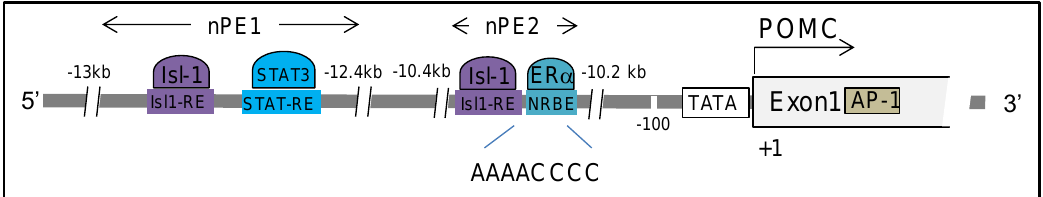
Figure 5. Illustration of hypothalamic POMC transcriptional regulation. Distinct from the pituitary POMC promoter, two target sequences nPE1 and nPE2 on the POMC enhancer contribute to hypothalamic POMC neuron transcriptional regulation. AP-1, activator protein-1; Isl-1, ISL LIM homeobox 1; Isl1-RE, Isl-1 responsive element; NRBE, nuclear receptor binding element; STAT3, signal transducer and activator of transcription 3; STAT-RE, STAT responsive element.